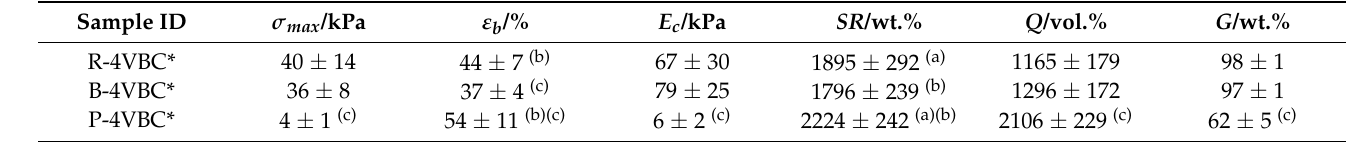
Table 2. Macroscopic properties of UV-cured hydrogels made of rat tail collagen (R-4VBC*), bovine atelo- collagen (B-4VBC*), and porcine atelocollagen (P-4VBC*). σ max —maximal stress; ε b —compression at break; E c —compressive modulus; SR —weight-based swelling ratio; Q —volumetric swelling; G —gel content.